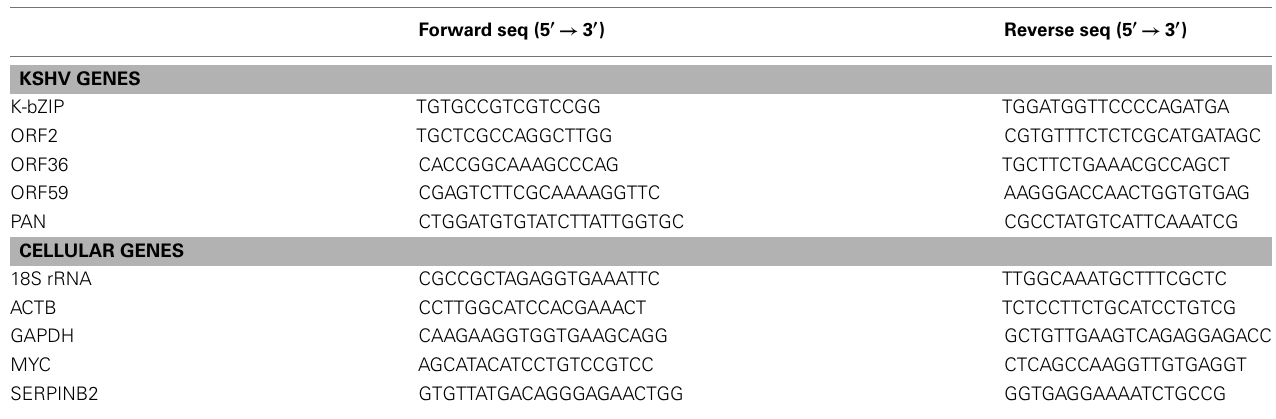
TableA1 | Sequences of primers used in Figures 3 and